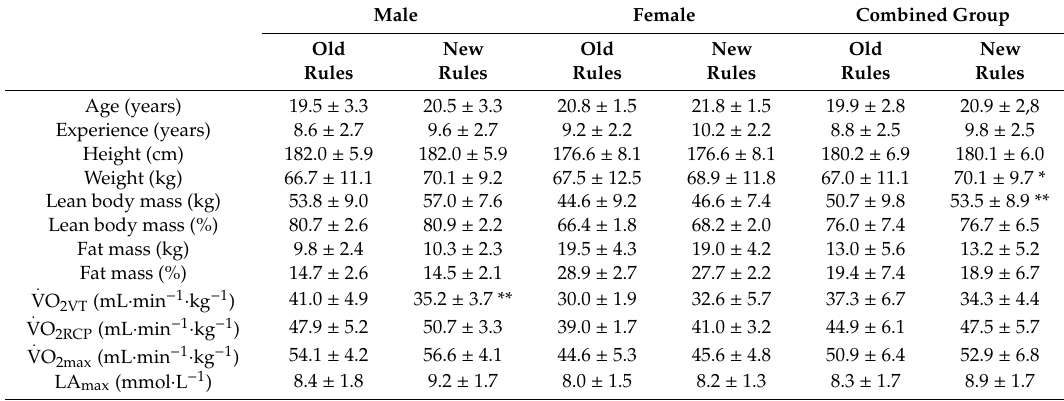
Table 1. Somatic and aerobic capacity profiles of the studied taekwondo athletes at the start of circuit training under old and new rules.